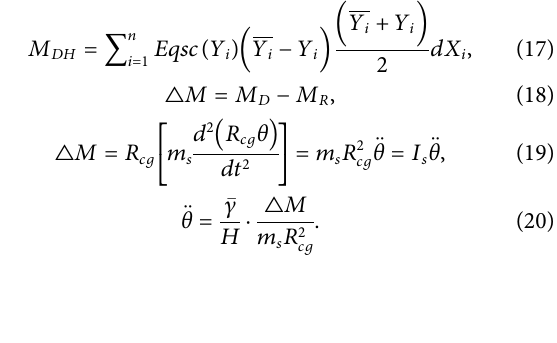
Frontiers in Earth Science |